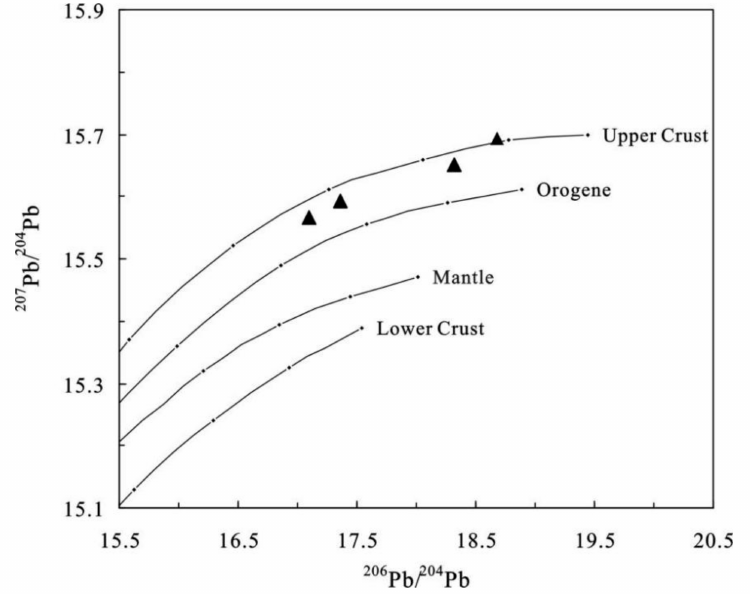
Figure 10. Pb isotopic diagram for biotite granite samples from the Gaudeanmus study area (after Zartman and Doe